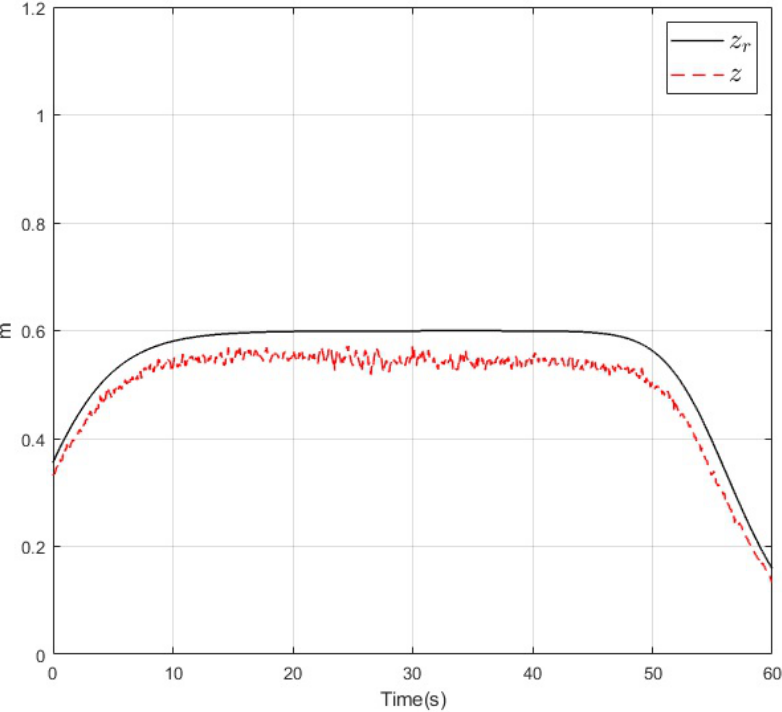
Figure 17. Altitude z (dashed) and its reference z r (solid) during the real-time